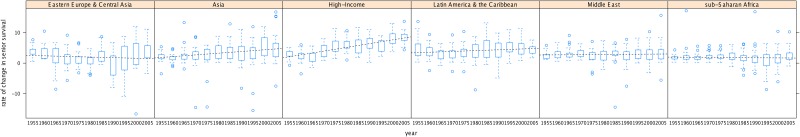
Regional changes in senior survival (deaths per 1000 per year), 1950–2010.Note: mean regional trends in changes in senior survival are indicated by the black dashed lines.